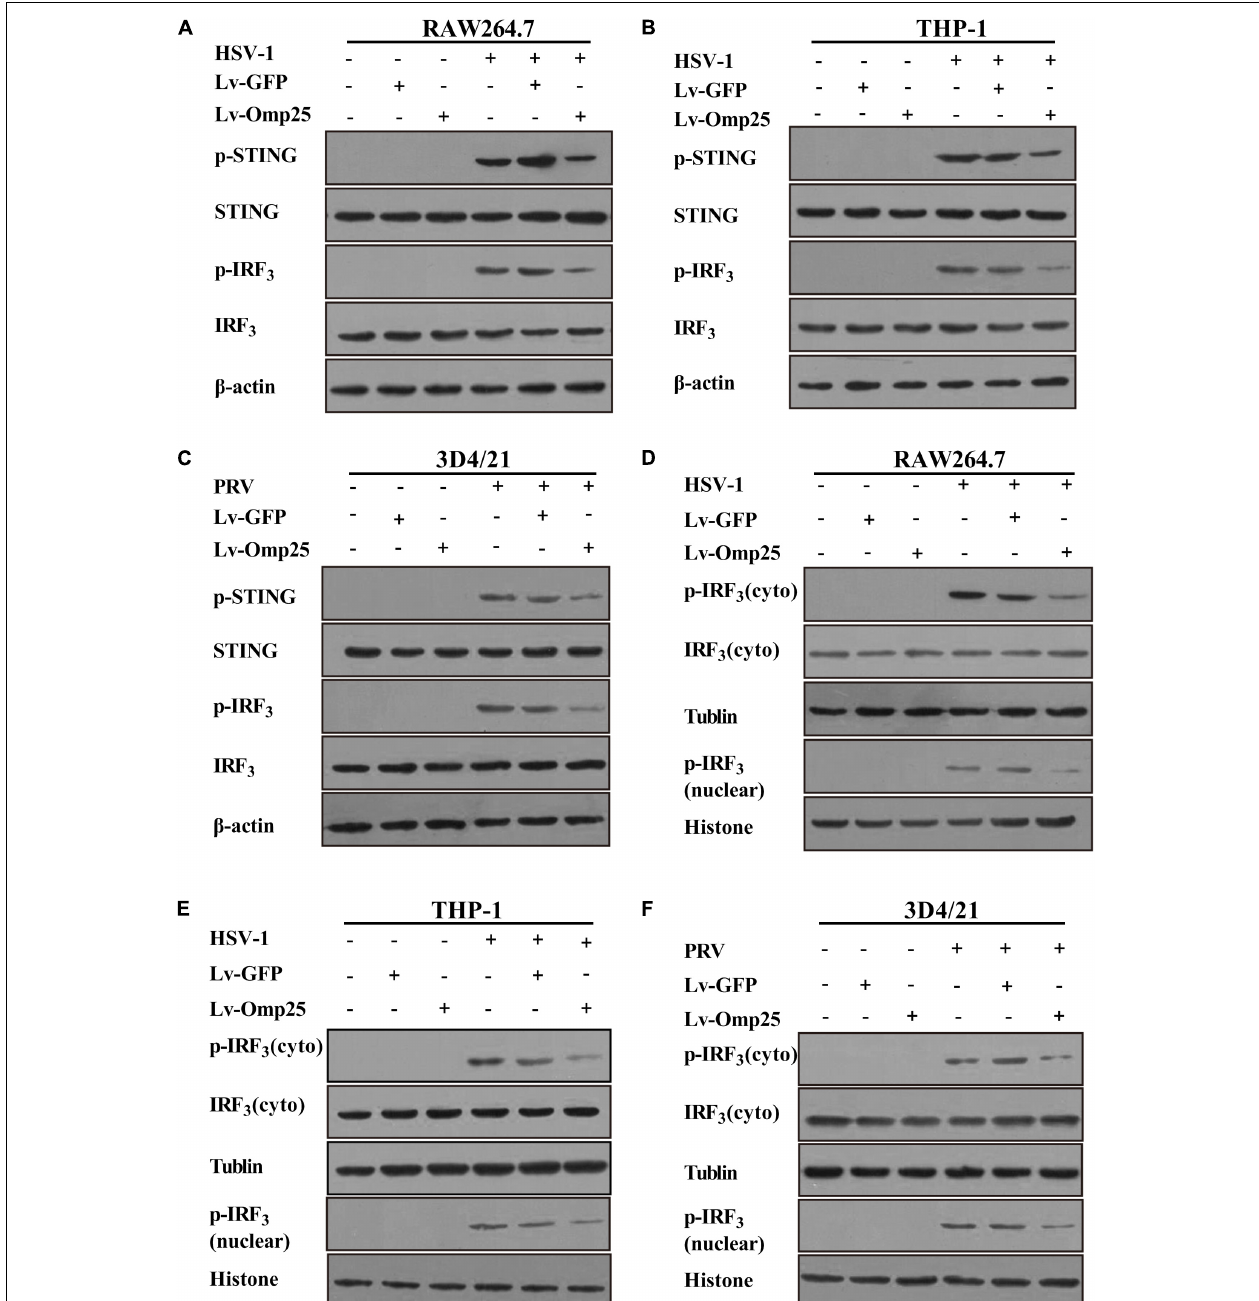
FIGURE 4 | Omp25 inhibits activation of cGAS/STING pathway. (A–C) Omp25 inhibits phosphorylation of STING and IRF3 (p-STING, p-IRF3) in murine, human, and porcine macrophages. Cells were infected with 100 MOI of Lv-Omp25 or Lv-GFP for 48 h and then further infected by HSV-1 (10 MOI) or PRV (1 MOI) for 6 h. Cells were harvested and subjected to detect level of p-STING and p-IRF3 by Western blotting. (D–F) Omp25 affects distribution of cytoplasmic and nuclear p-IRF3. Cells were infected and treated as in panels (A–C) , cytoplasm and nuclear were separated, and level of p-IRF3 in cytoplasm and nuclear were detected by Western